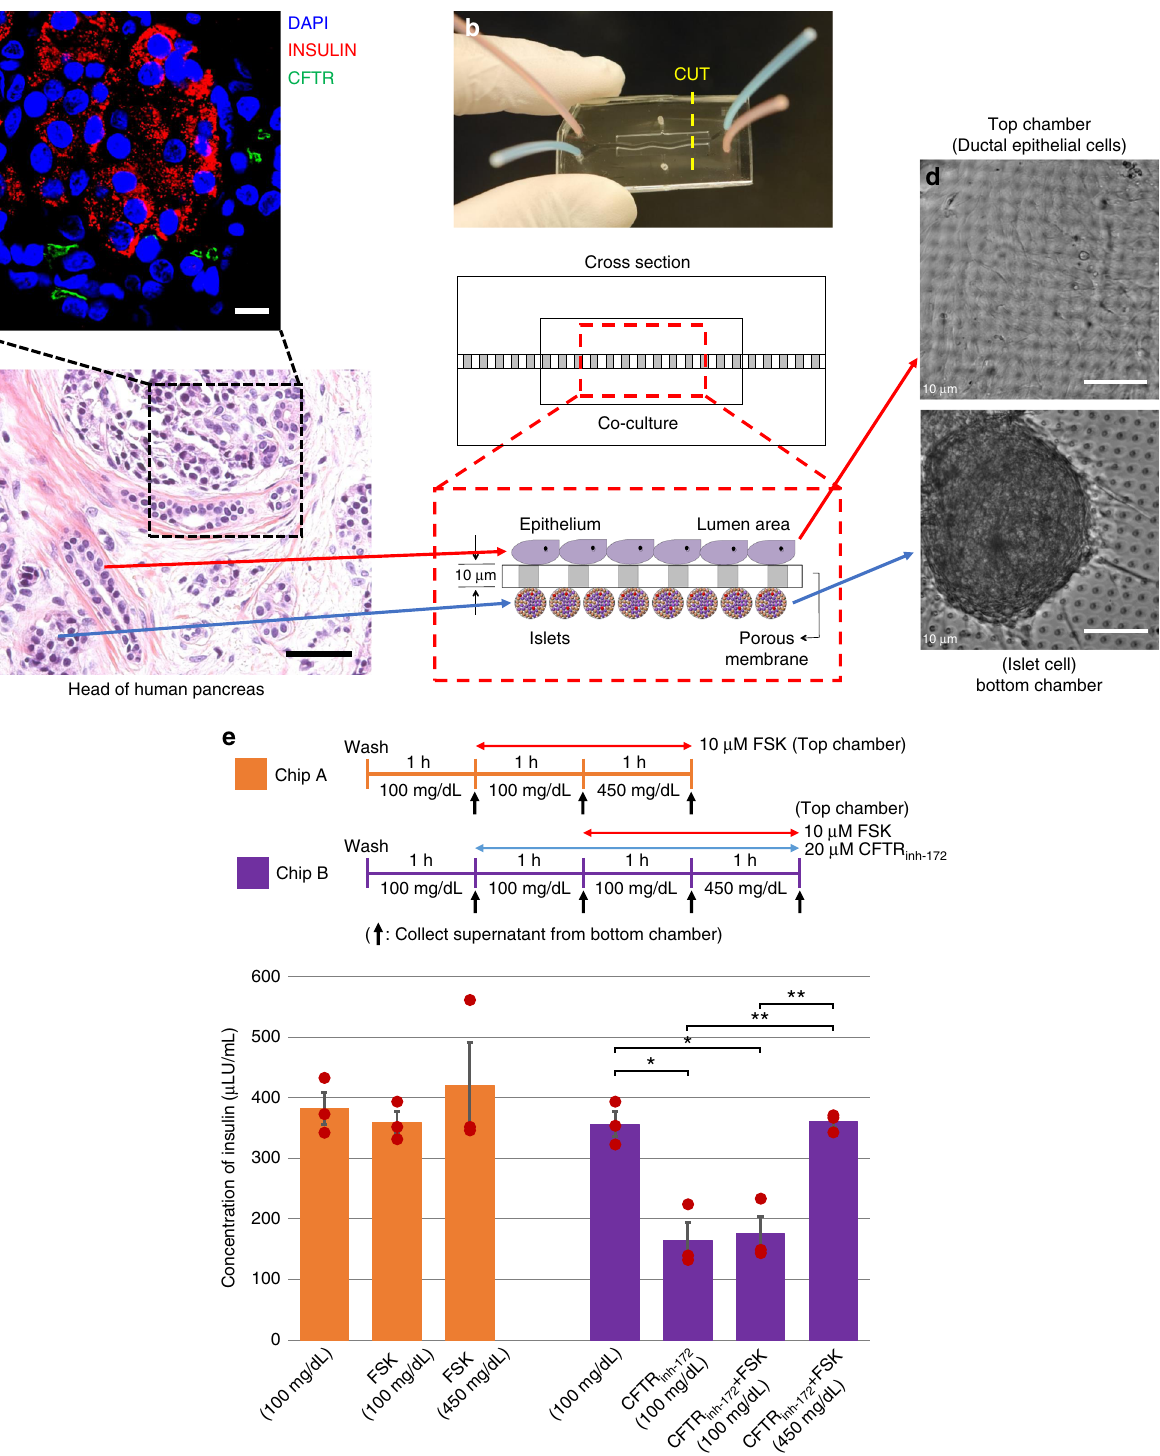
Fig. 5 Pancreas-on-a-chip to study cystic fi brosis-related diabetes (CFRD). A small piece of non-treated head of pancreas was obtained and examined by a immuno fl uorescence microscopy with insulin and cystic fi brosis transmembrane conductance regulator (CFTR) and c hematoxylin and eosin (H&E) stain. It shows that pancreatic islets are located in close proximity to the pancreatic duct. To mimic pancreatic structure and function, b pancreas-on-a-chip has been developed that is comprised of two-cell culture chambers and a thin layer of porous membrane. d Pancreas-on-a-chip allows us to co-culture pancreatic ductal epithelial cells (PDECs) on the top chamber with pancreatic islets in the bottom chamber. e Endocrine function of islet cells was monitored with stimulation or inhibition of CFTR function in PDECs on the top chamber. We observed that CFTR channel function has a direct effect on the endocrine function. Secreted insulin was dramatically decreased (53.7%) by inhibition of CFTR function of PDECs. This in vitro model system, pancreas-on- a-chip, allows us to study cell – cell interaction. Scale bars: 10 µ m ( a ), 50 µ m ( c ), and 100 µ m ( d ). ( p values from one-way analysis of variance (ANOVA) and adjust using Bonferroni factor: *<0.05, **<0.005; number of chips: Chip A ( n = 3) and Chip B ( n = 4); data are mean ±